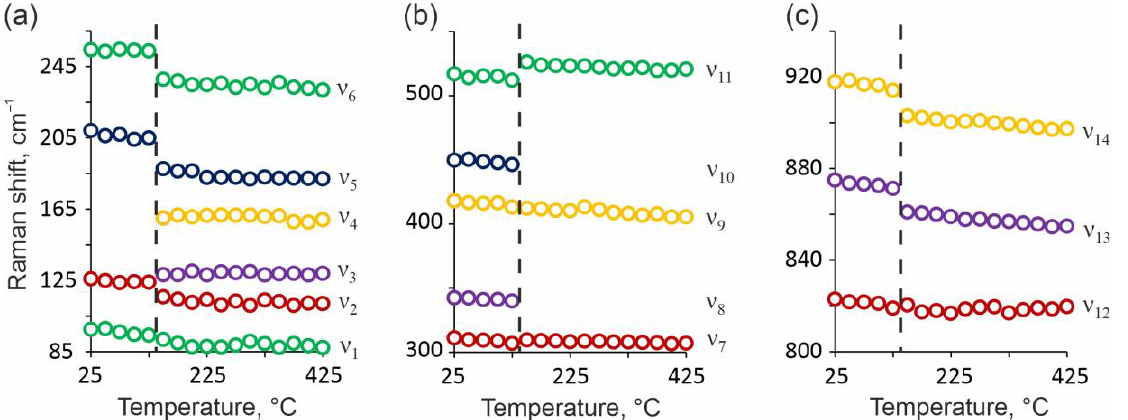
Figure 2. Temperature evolution of some selected Raman bands from 85 to 265 cm − 1 ( a ), from 300 to 550 cm − 1 ( b ), and from 800 to 940 cm − 1 ( c ). The broken vertical lines demonstrate the abrupt changes in the temperature evolution of the Raman bands. The errors are smaller than the size of the